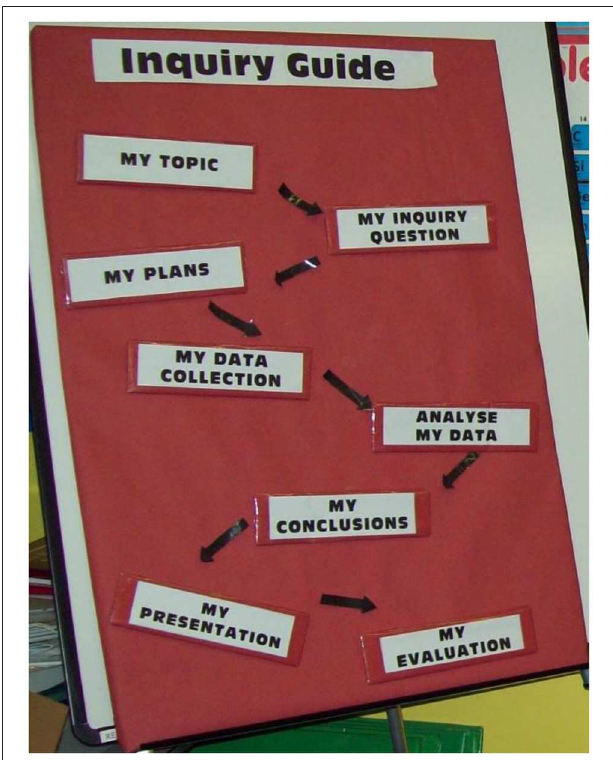
FIGURE 4 | The Inquiry Guide as presented in the Nottingham class in 2008.